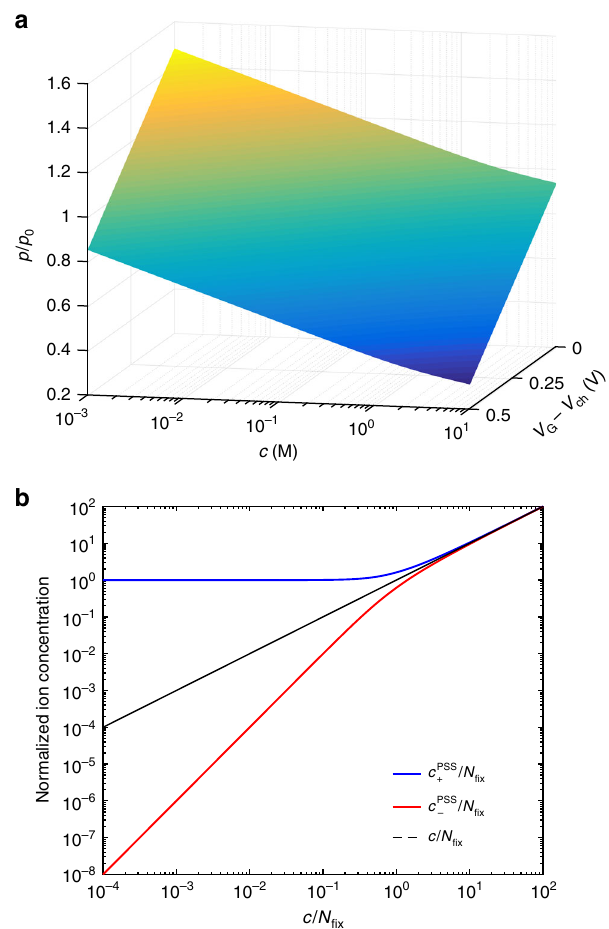
Fig. 5 Hole and ion concentration in the OECT channel. a Hole concentration in the PEDOT:PSS channel normalized to the intrinsic hole concentration as a function of c and V G − V ch . The hole concentration is calculated according to Eq. (7) at a channel coordinate x = L /2 when the OECT is biased at V D = − 0.1 V. b Mobile ion concentration in the electrolyte (black dashed line), and mobile cation (blue line) and anion (red line) concentration in the PSS polyelectrolyte normalized to the fi xed charge concentration into the polymer N fi x . The concentrations are calculated with Supplementary Equations (19), (20), (21)